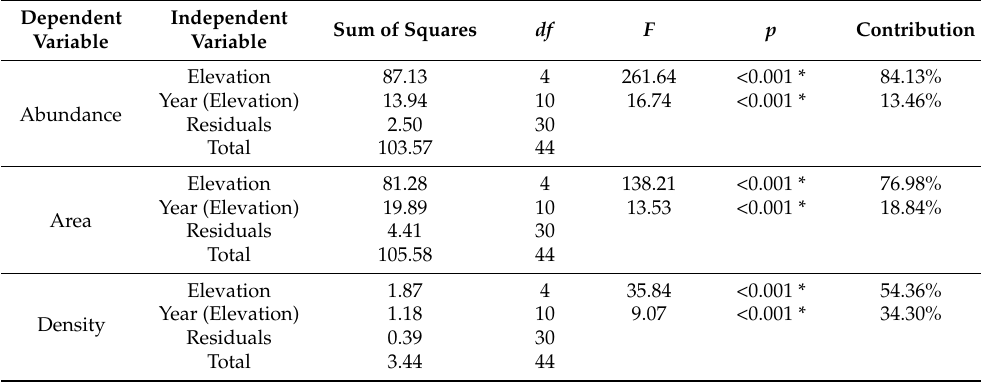
Figure 6. Changes in penguin abundance ( a ), colony area ( b ) and density ( c ) with elevation. Histograms represent the total value and the lines are the relative proportion. Table 5. Summary results of nested ANOVA analyses for determining the contribution of elevation and year to penguin abundance, colony area and density between different elevation ranges in study years. Year (Elevation) represents year nested in elevation in nested ANOVA analyses. * p < 0.01 according to nested